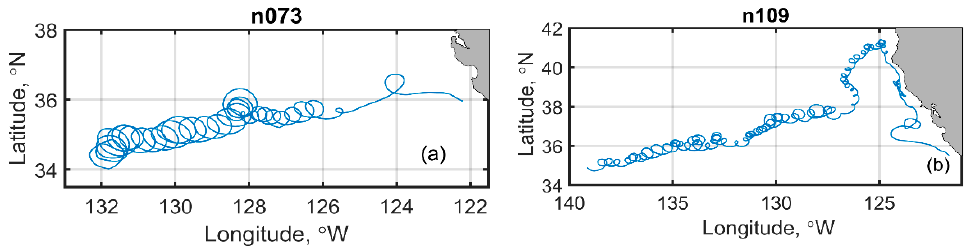
Figure 3. Trajectories of RAFOS float #73 ( a ) and #109 ( b ) in the California Current system.